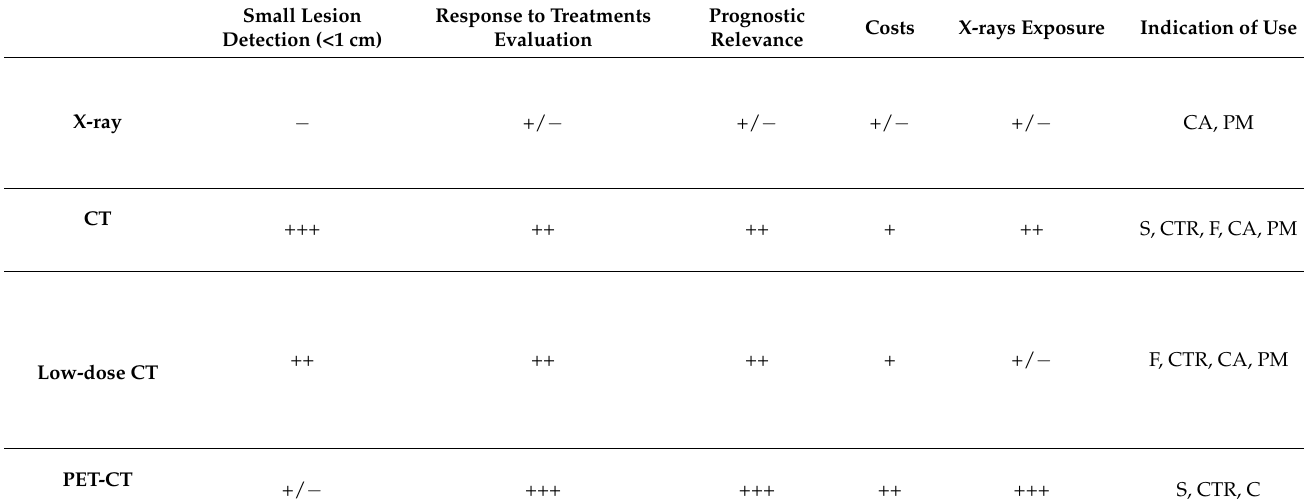
Table 1. Imaging tools in the assessment of osteosarcoma lung metastases. Small Lesion Detection (<1